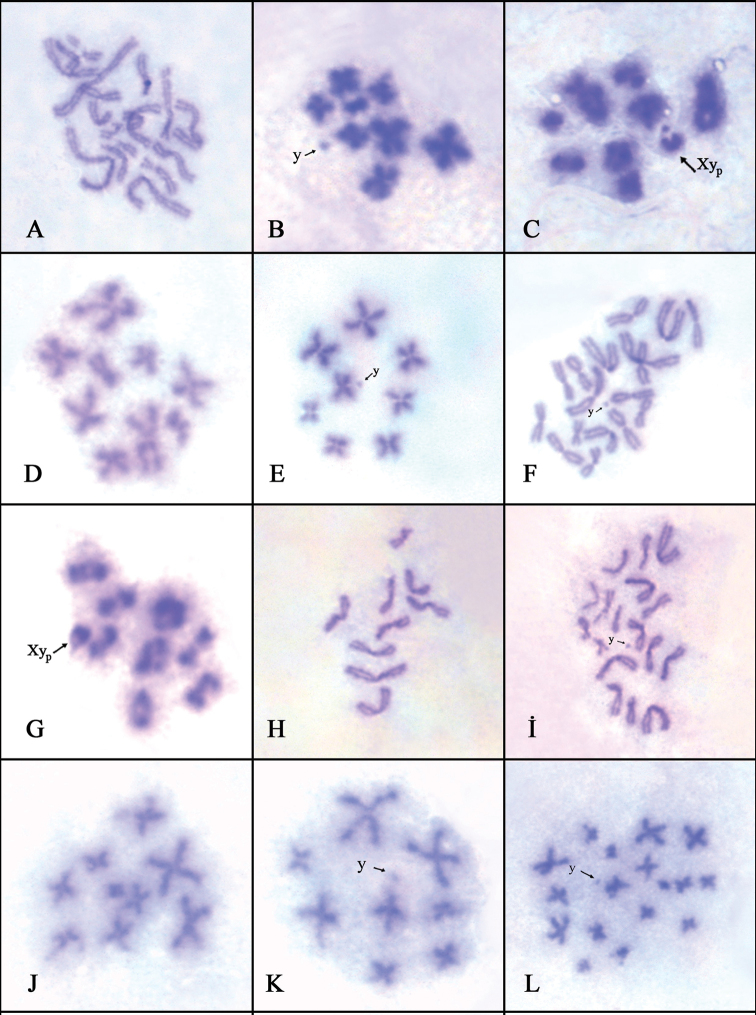
A Female Mitotic metaphase of Trichodes
favariusB, C male meiotic metaphases of Trichodes
favarius (B meiosis II; C meiosis I) D, E male meiotic metaphases of Trichodes
quadriguttatus (D, E meiosis II) F male mitotic metaphase of Trichodes
quadriguttatusG, H male meiotic metaphases of Trichodes
reichei (G meiosis I; H meiosis II) I male mitotic metaphase of Trichodes
reicheiJ, K male meiotic metaphases of Tilloidea
transversalis (J, K meiosis II) L male mitotic metaphase of Tilloidea
transversalis.